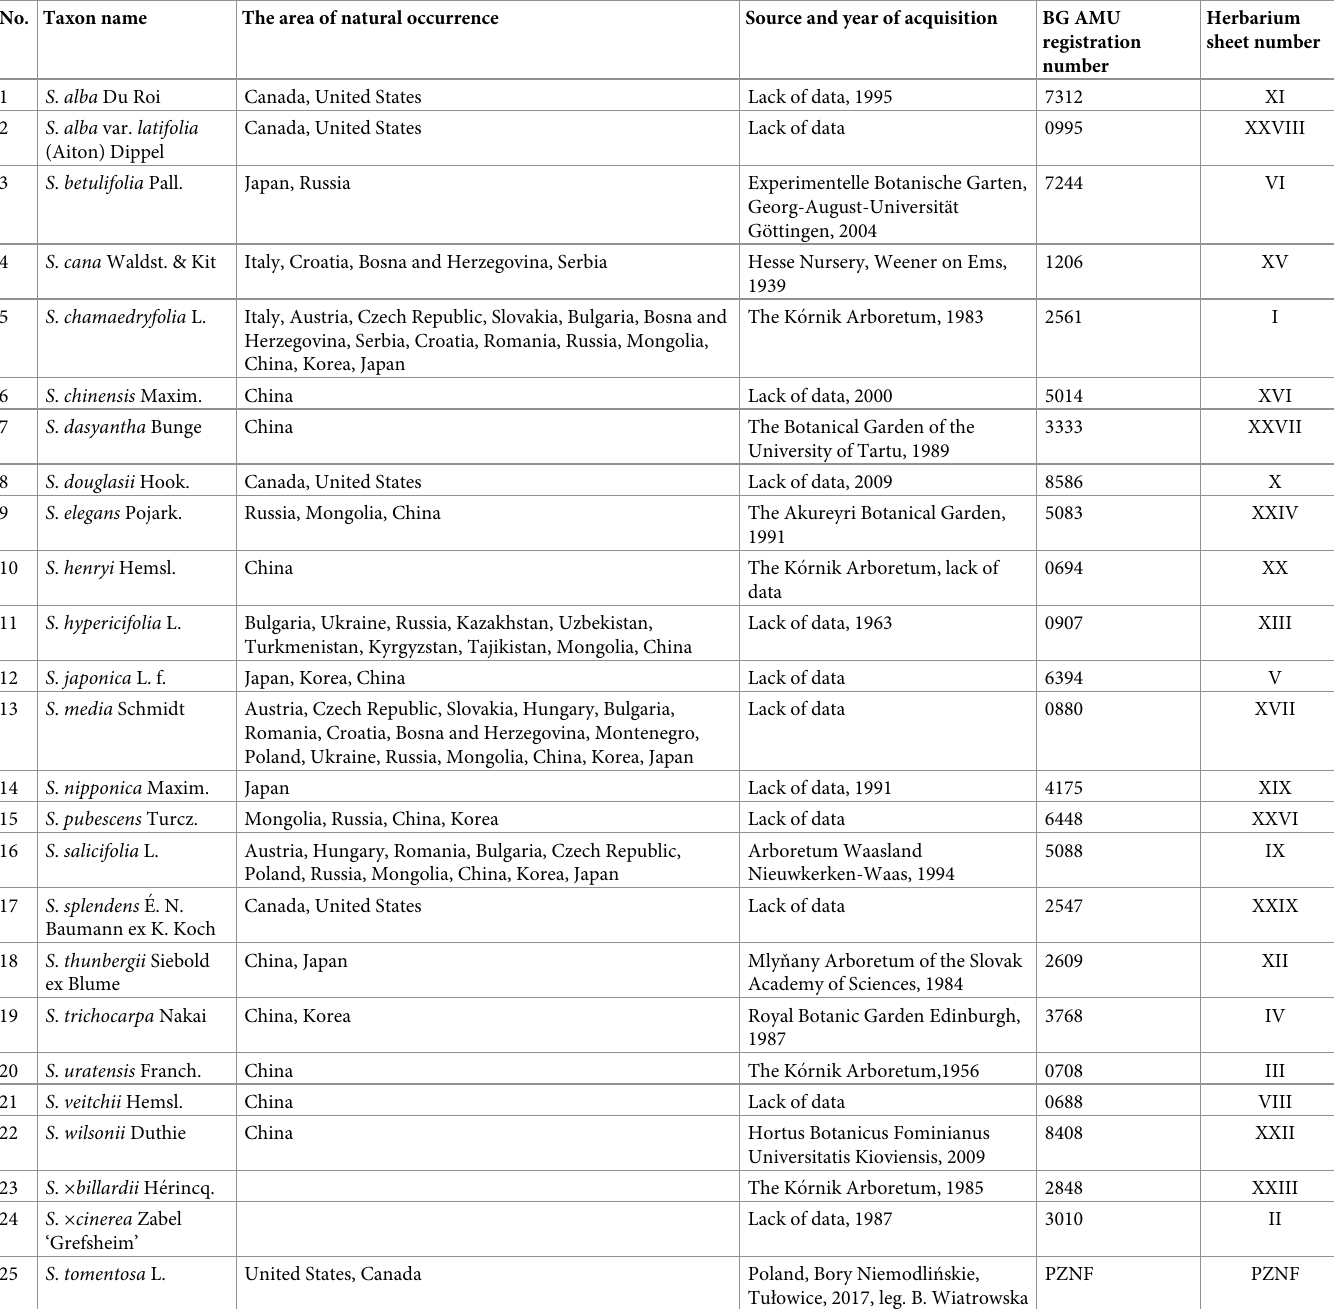
Table 1. List of Spiraea taxa under analysis collected from the herbarium of the Botanical Garden of the Adam Mickiewicz University in Pozna ń and natural